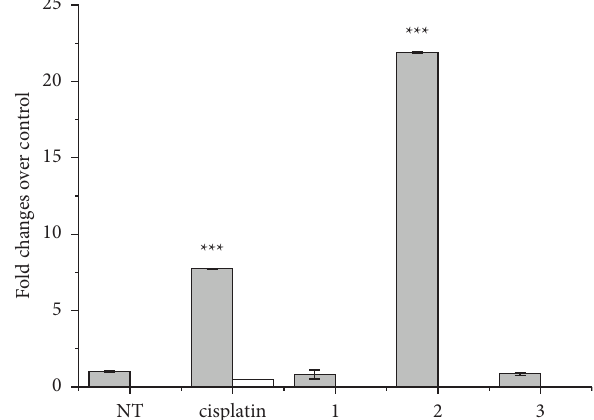
(Figure 1) using wortmannin as an inhibitor of endocytosis and micropinocytosis [23]. Tese data suggest that the ab- normal high cell accumulation of 2 is based on carrier- mediated transport.